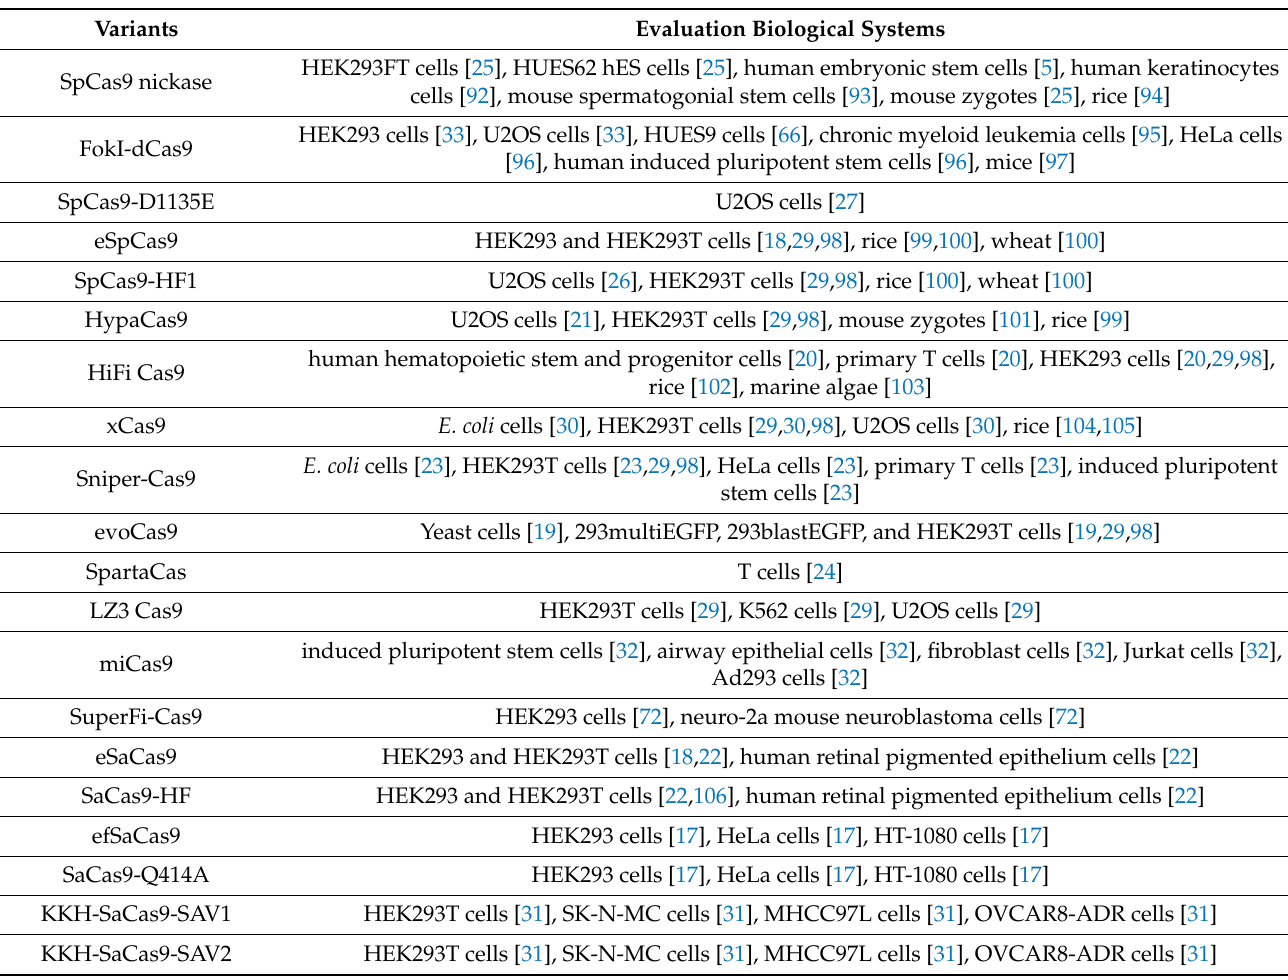
Table 4. Summary of biological systems in which the high-fidelity SpCas9 and SaCas9 variants have been